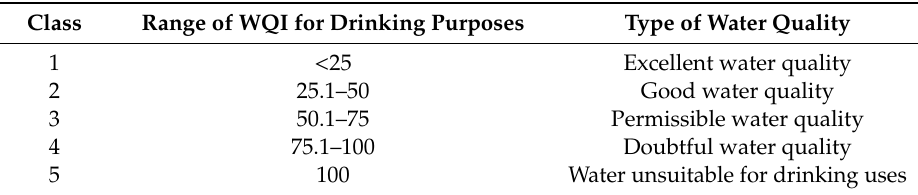
Table 4. Recommended classes of drinking water quality according to the water quality index (WQI) standards